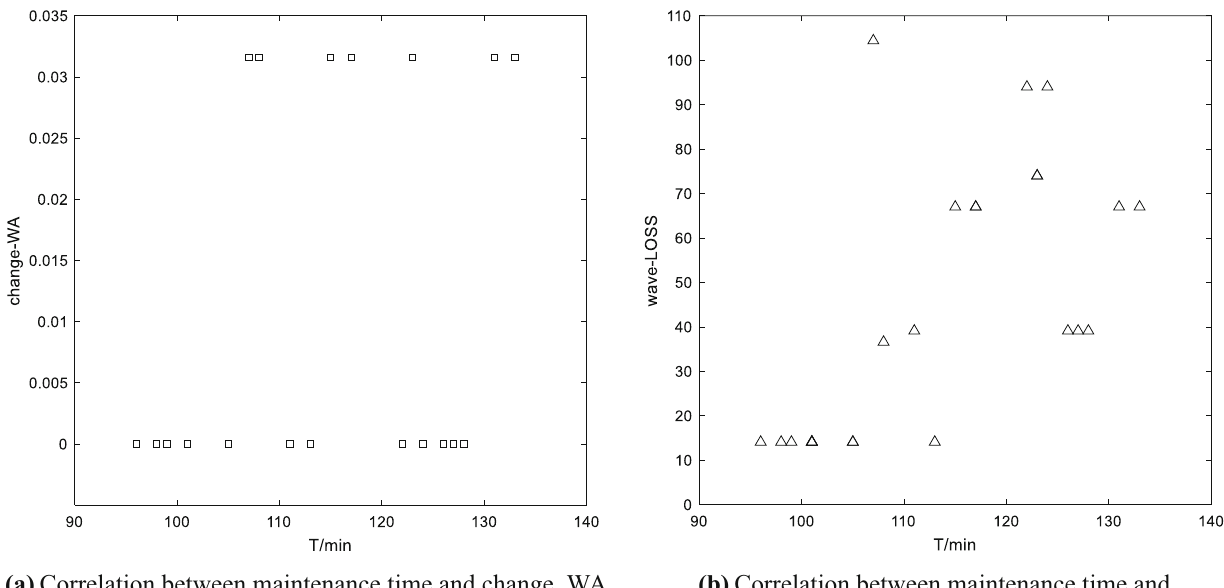
Fig. 18 Bar chart of maintenance time for maintenance personnel in baseline scheduling